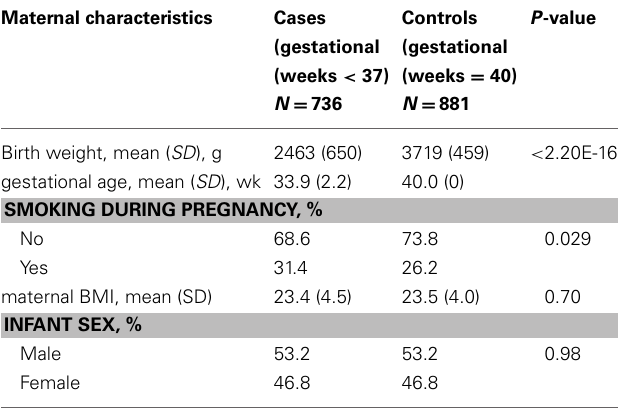
Table 1 | The characteristics of the DNBC/GENEVA mothers